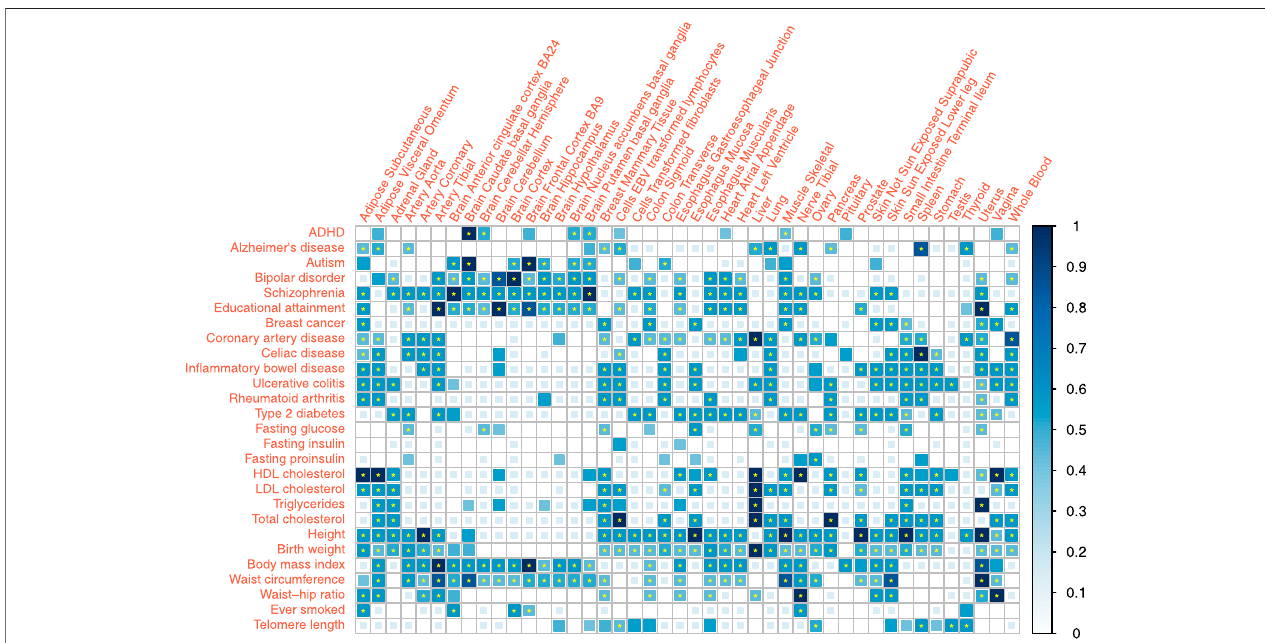
FIGURE3| Tissue-traitassociationscoringcombiningspeci fi cityestimatesofthreedistinctmethods.Associationbetween27traitsand44tissueswerequanti fi ed byassociationscore.The associationscoresums thebinary resultsfromdifferentmethods, weightedbythespeci fi cityestimates. The p -valuethresholds are0.05 forall three methods (eQTL, LDSC, and RolyPoly). * represent < 0.05 for the combined false discovery rate (FDR) of the association